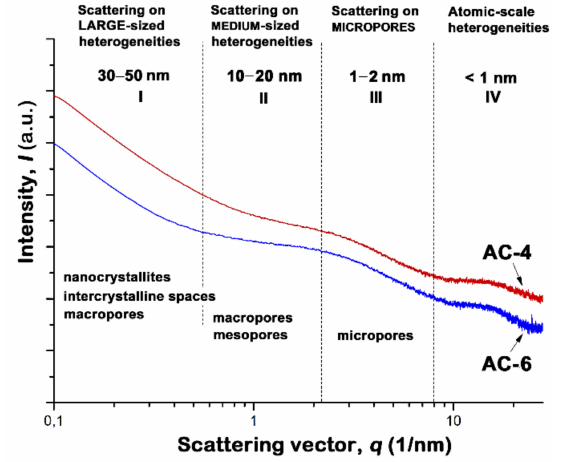
Figure 3. The log-log plot of scattering intensities versus scattering vector q for the peat-derived activated carbons obtained at di ff erent steam activation